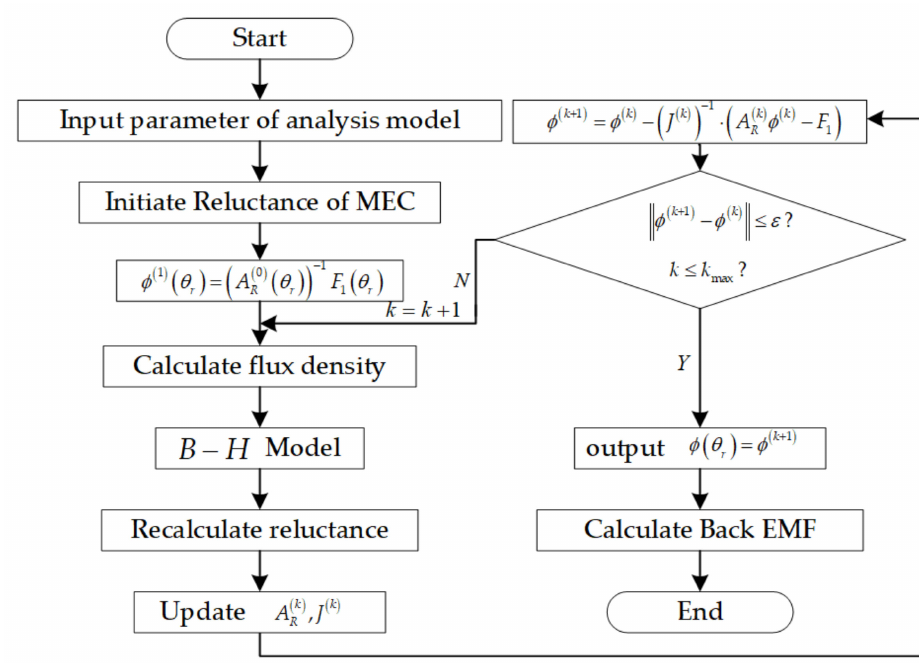
Figure 9. Analysis procedure of 3D-MEC.